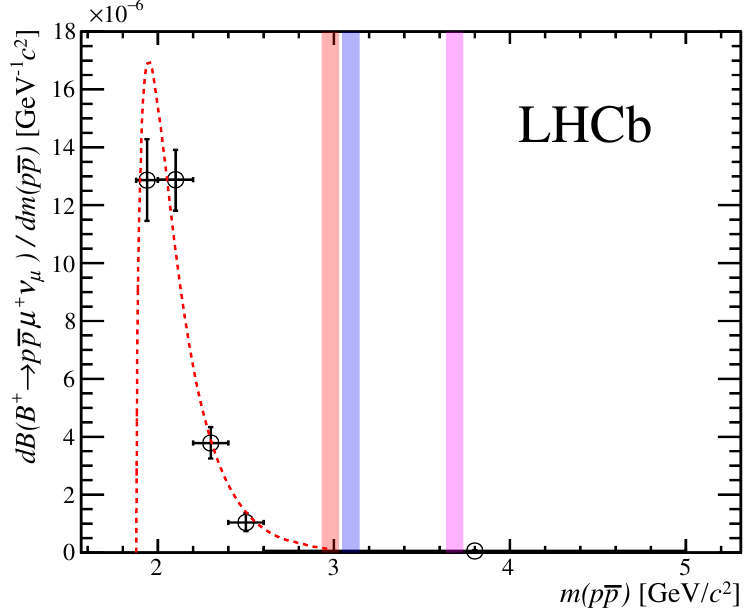
Figure 4 . Di(cid:11)erential branching fraction as a function of the pp invariant mass. The (cid:17) c ! pp , J= ! pp and (2 S ) ! pp vetoes are indicated by the (left) red, (middle) blue and (right) pink bands, respectively. The red dashed line represents the prediction of the pQCD model normalised to the observed branching fraction